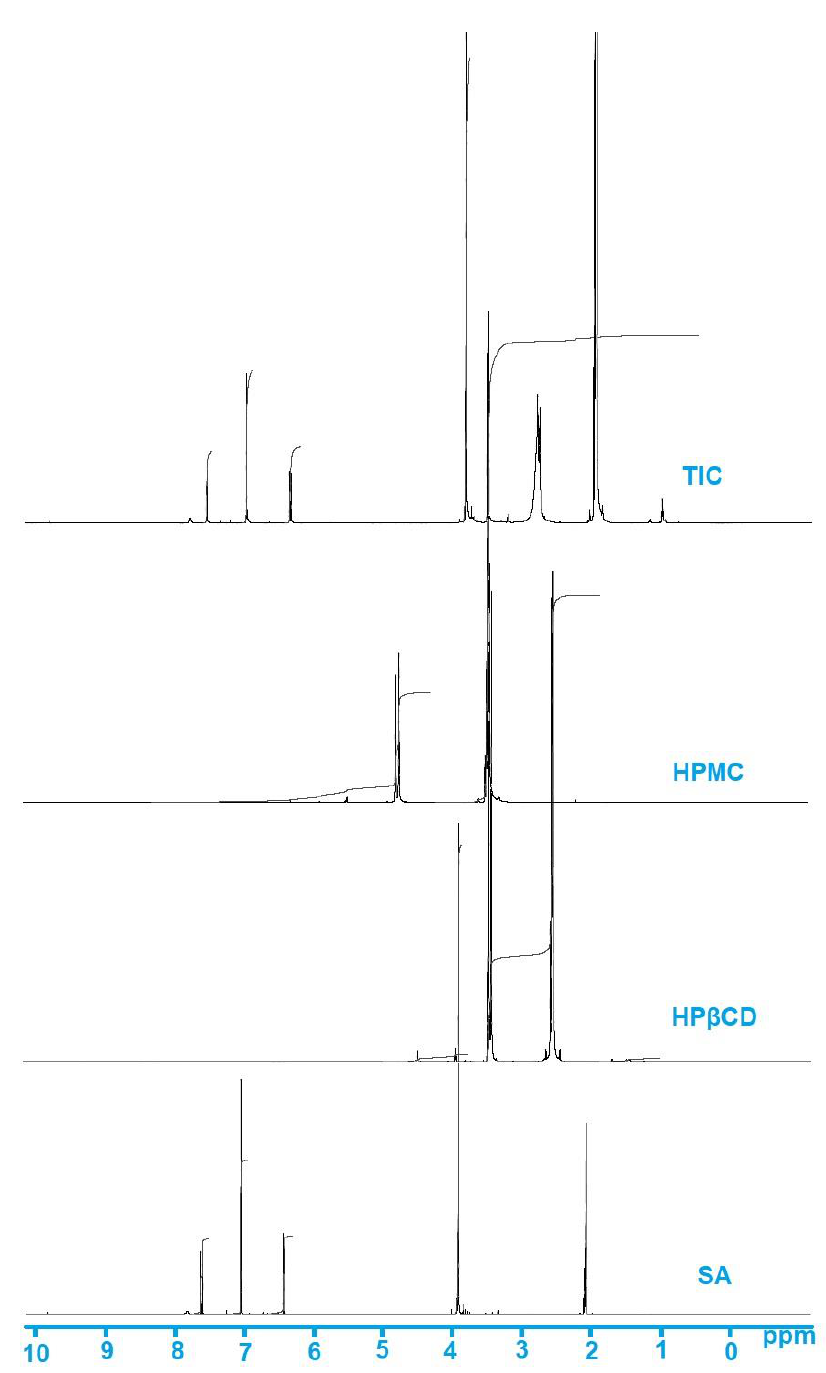
Figure 5. NMR spectra of SA, HPβCD, HPMC , and TIC.